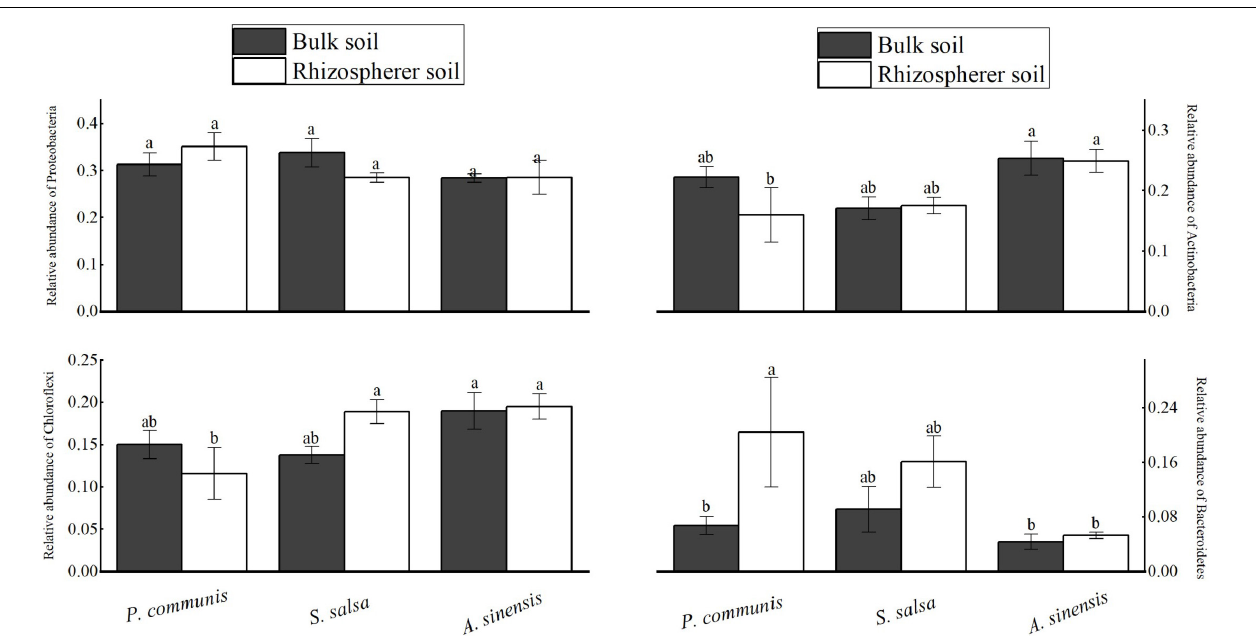
FIGURE 5 | Comparative analysis of relative abundance (RA) > 10% in the rhizosphere and bulk soils of different halophytes. Different letters denote significant differences at P < 0.05. which can absorb soil salt and secrete the salt in vitro (Wu et